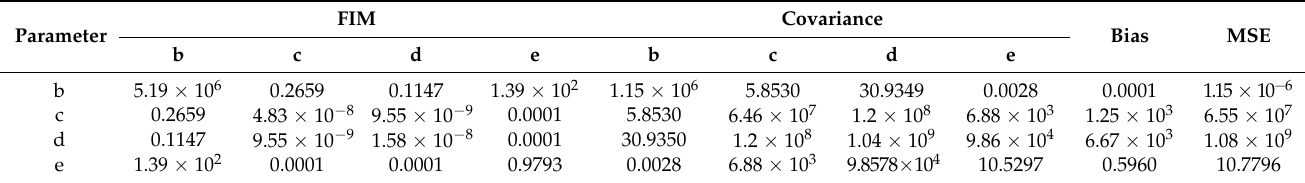
Table 4. Asymptotic approximations of the parameter accuracy metrics of uniform sampling.